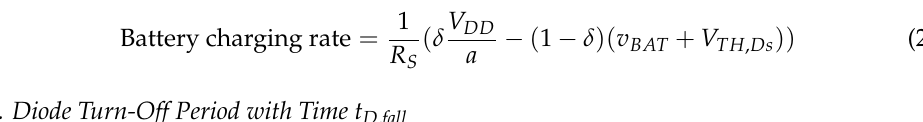
Table 3. Calculation of the charging current provided with parameters in Tables 1 and 2.